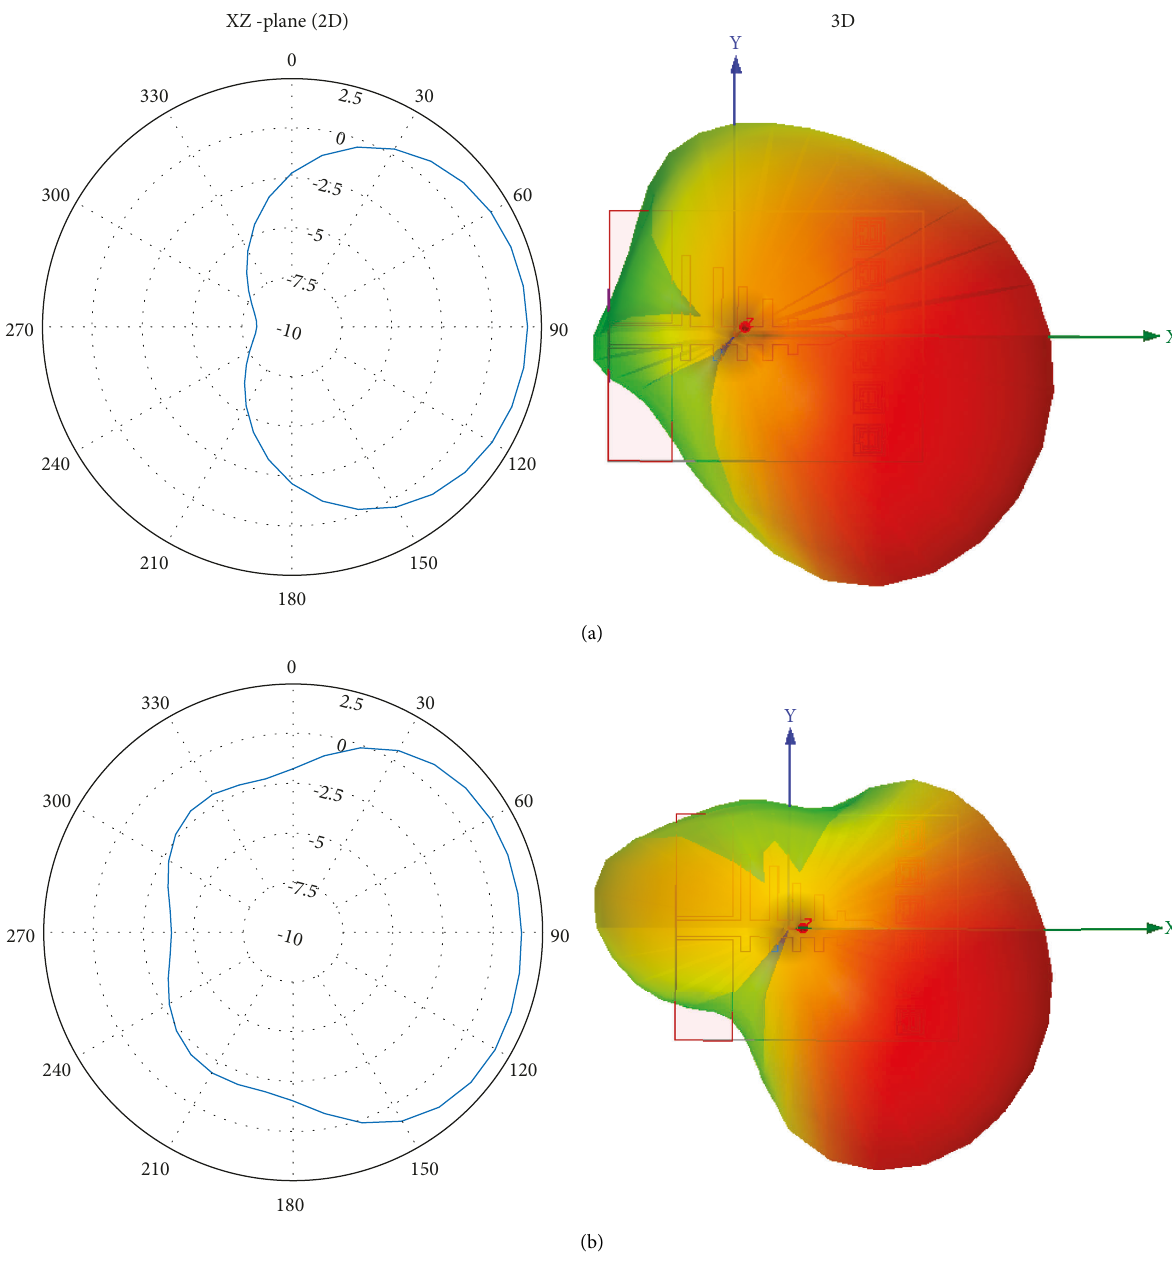
Figure 12: Radiation patterns of the PLPA in 2D and 3D at (a) 3.5GHz and (b) 5